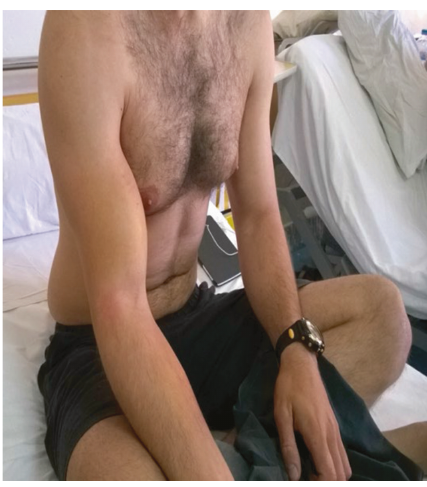
Figure 1: Acute biceps rupture in a military parachutist. Popeye deformity is noted.